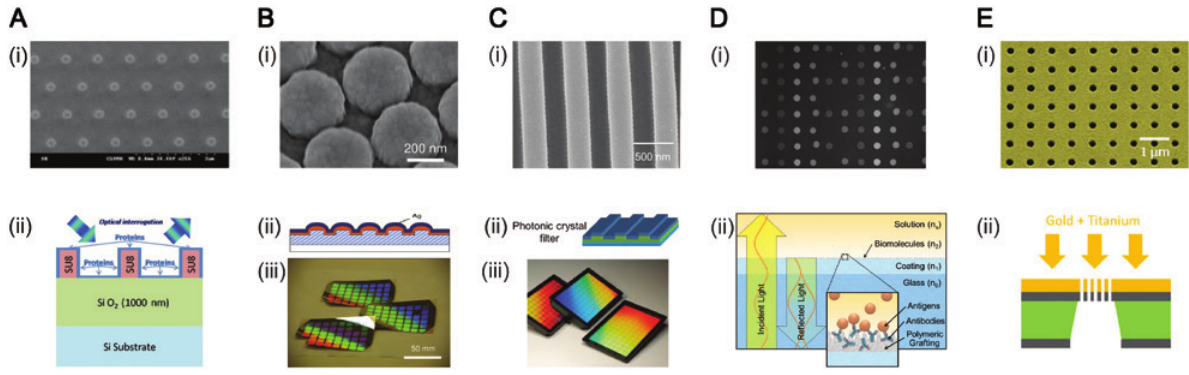
Figure 2: Material substrates for cost-effective and portable biosensors. (A) Photonic structure made by nanopillars of SU-8 resist on SiO . (i) SEM image and (ii) schematic representation. Reprinted from Sensors 2 Actuators B Chem, 176, Á. Lavín, R. Casquel, F.J. Sanza, M.F. Laguna, and M. Holgado, Efficient design and optimization of